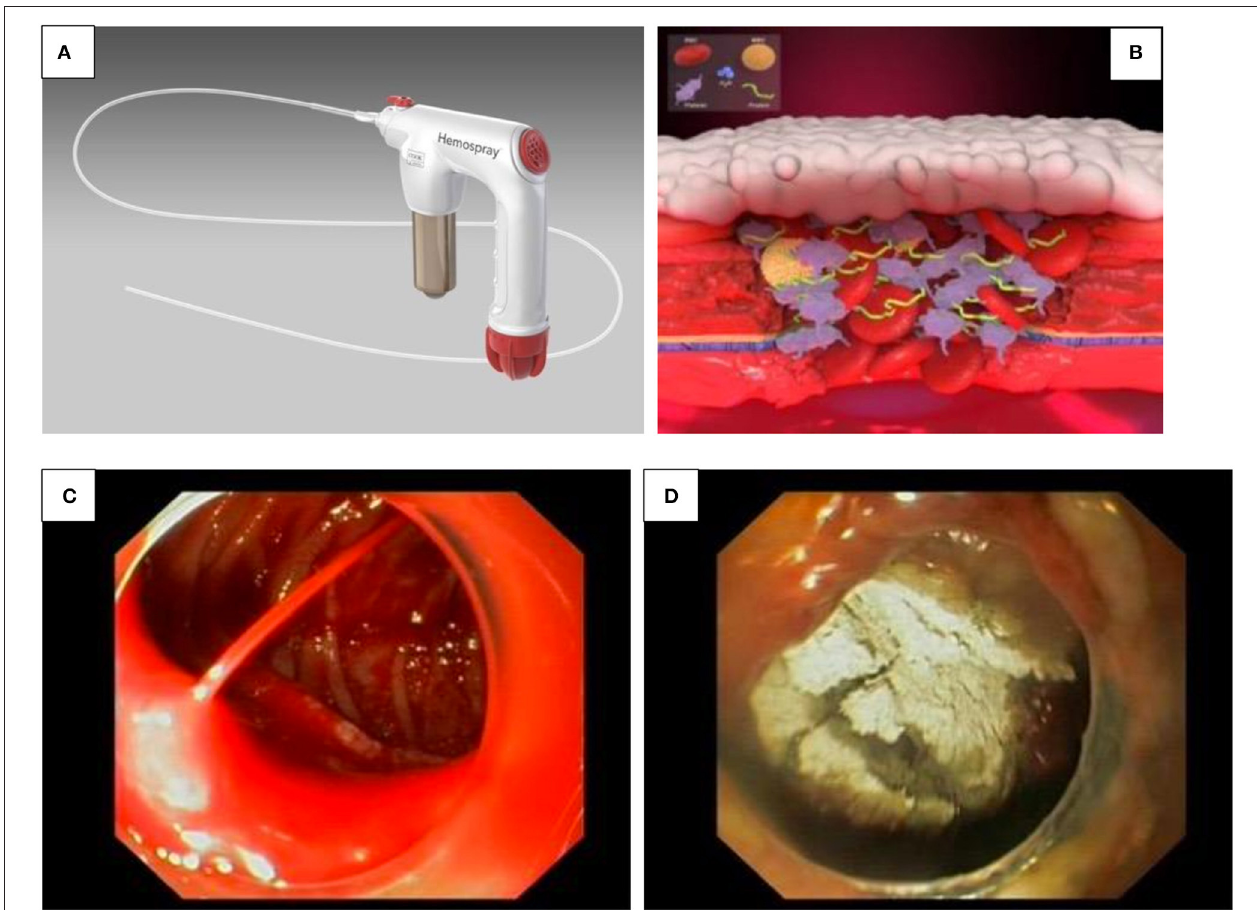
FIGURE 3 | (A–D) Hemospray ® . (A) Hemospray ® device. (B) Activation of the coagulation cascade by Hemospray ® results in immediate clotting. (C,D) Significant GI bleeding before (A) and after Hemospray ® procedure (B)